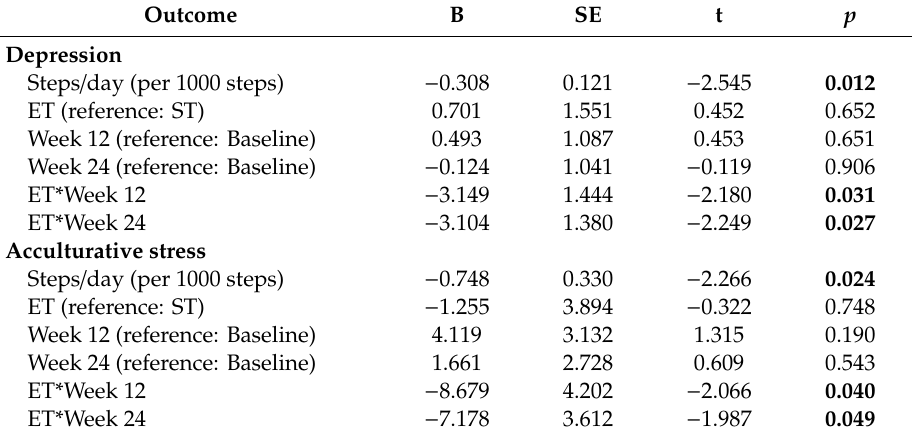
Table 2. Changes in depression and acculturative stress scores over